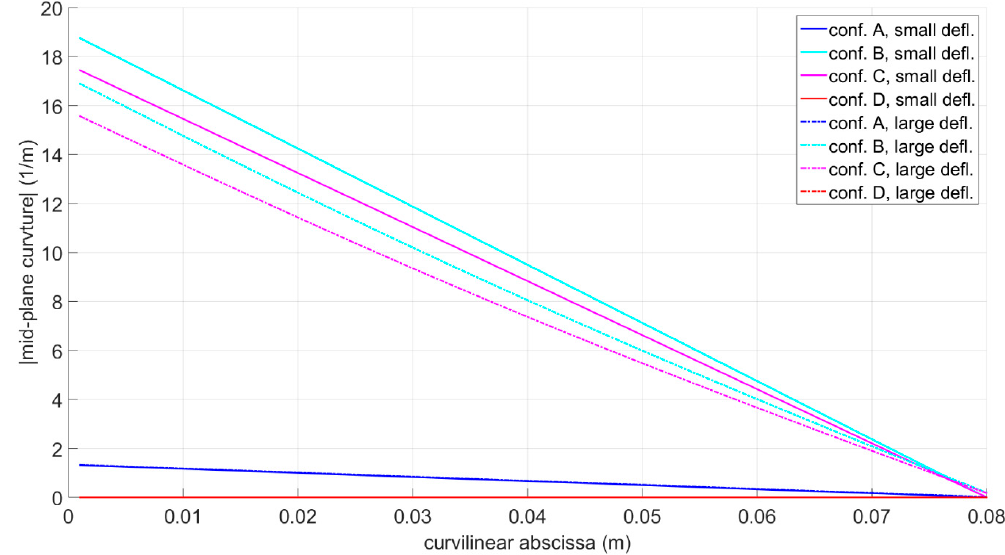
Figure 6. Curvature distribution at the conditions A, B, C, and D of the process of Figure 4, in small and large displacement assumptions.